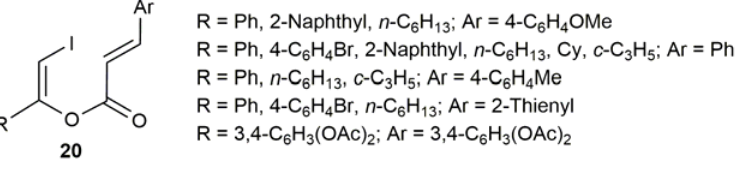
Figure 3. Structure of the (Z) - β -iodoenol cinnamates 20 .